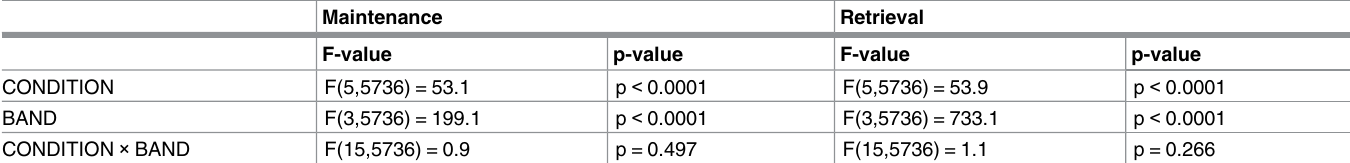
Table 1. Results from the factorial ANOVA comparing Condition and Frequency Band.